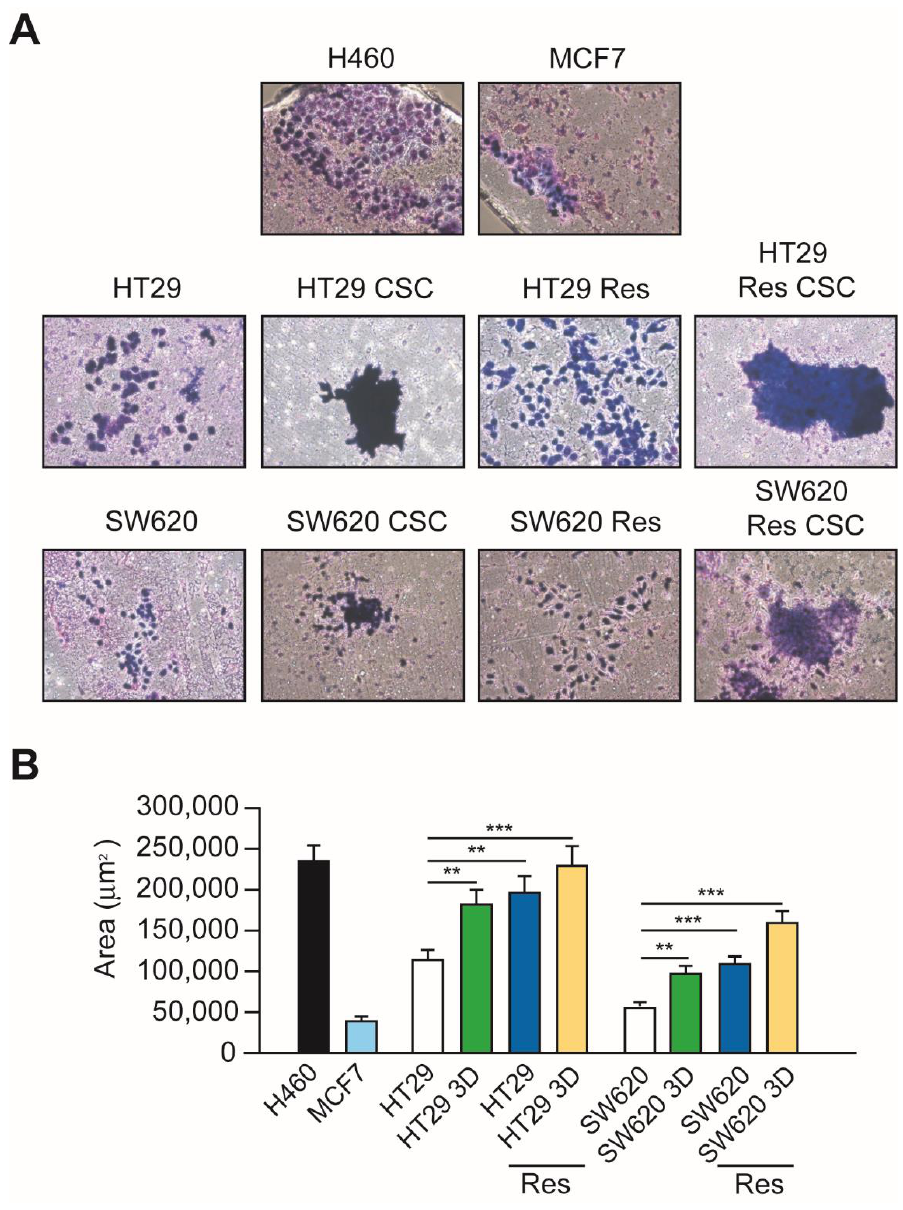
Figure 4. Determination of cell invasion capacity. The invasion capacity of the cells was determined using Matrigel invasion chambers and Foetal Calf Serum as a chemoattractant. HT29 and SW620 original cell lines, cells cultured under non-adherent conditions (3D), oxaliplatin-resistant cells (Res), and resistant cells grown under non-adherent conditions (Res3D) were used in these experiments. The H460 non-small cell lung cancer cell line was used as positive control and MCF7 as negative control. Panel ( A ) shows representative images of cells that migrated through the Matrigel cushion. Panel ( B ) shows the quantification of the cells that migrated (average of ten different fields). Experiments were repeated three times with similar results. Statistics: ** p < 0.01; *** p <